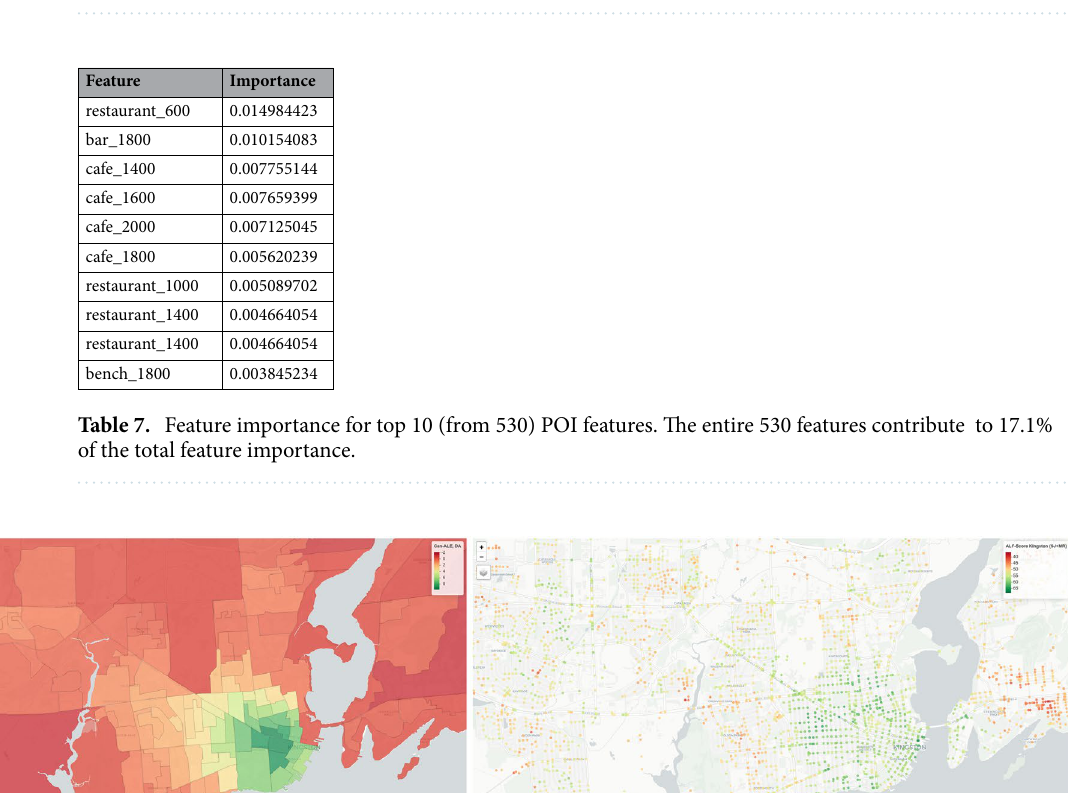
Table 6. Feature importance for all centrality features (10 features in total) which contribute to 4.1% of the total feature importance.